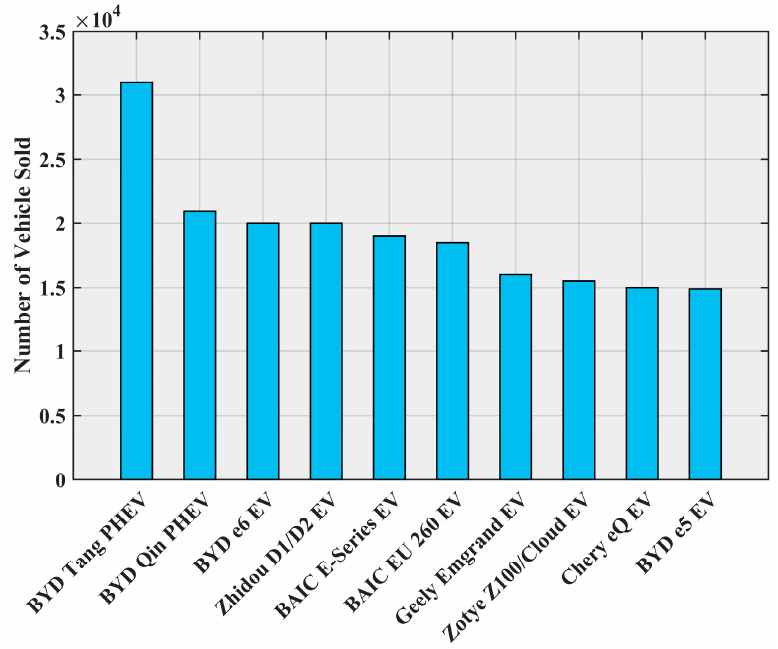
Figure 75. Top ten EVs in China in 2016 according to the number of units sold. Data from [190].